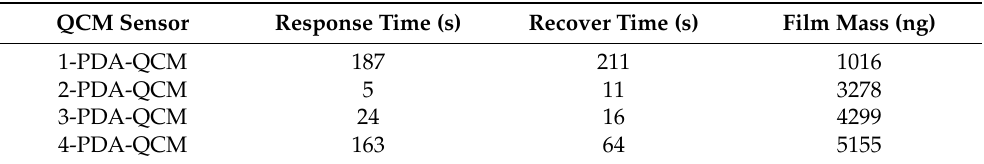
Table 1. Summary table of response/recovery times and film mass of PDA-QCM humidity sensors with different growth